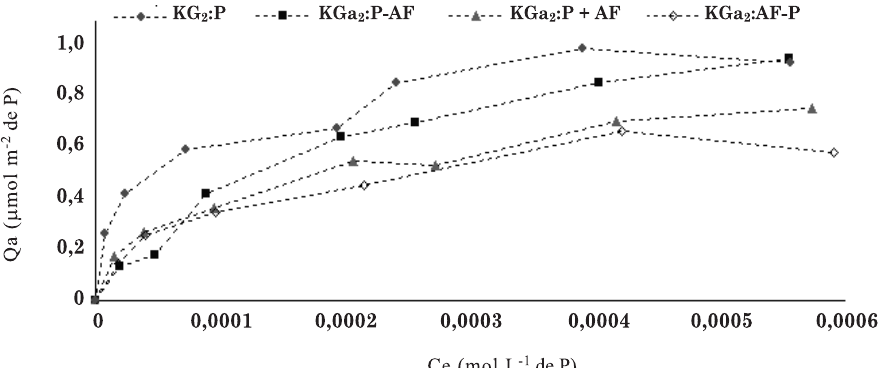
Figura 3. Isotermas de adsorção de fósforo sobre caulinita natural (KGa